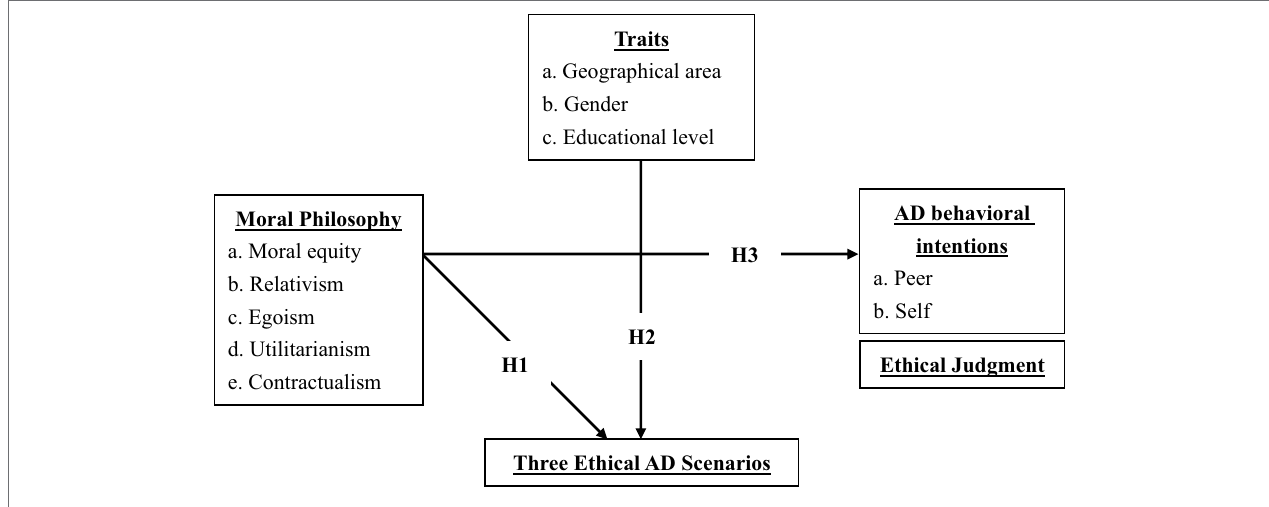
FIGURE 1 | Research hypothesis